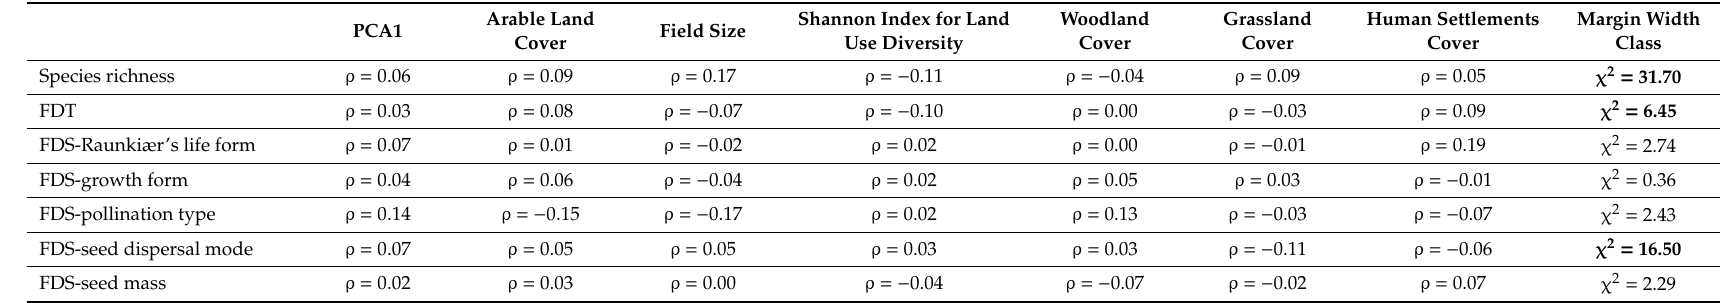
Table 3. Correlations of species’ richness, functional diversity for the whole trait set (FDT) and for individual traits (FDS) of field margin plant assemblages with PCA first axis (PC1) and with landscape and local variables. Spearman’s rank correlations ( ρ ) were used except for margin width class, for which correlations were determined by the Kruskal-Wallis ( χ 2 ) test. In bold, p -values < 0.05.